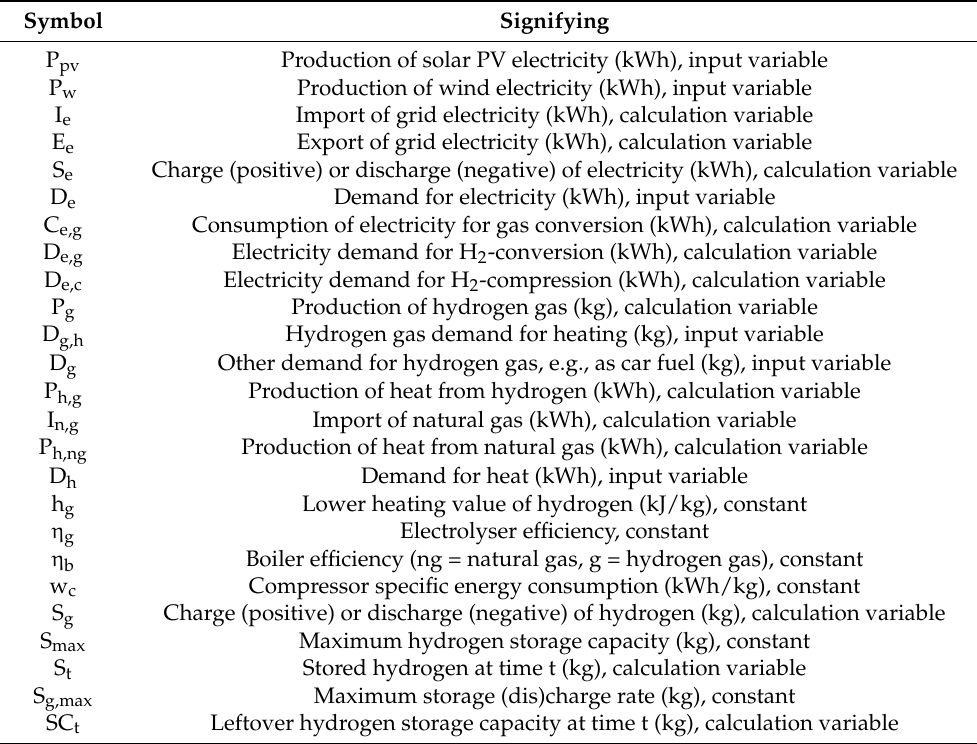
Table 2. Nomenclature (Figure